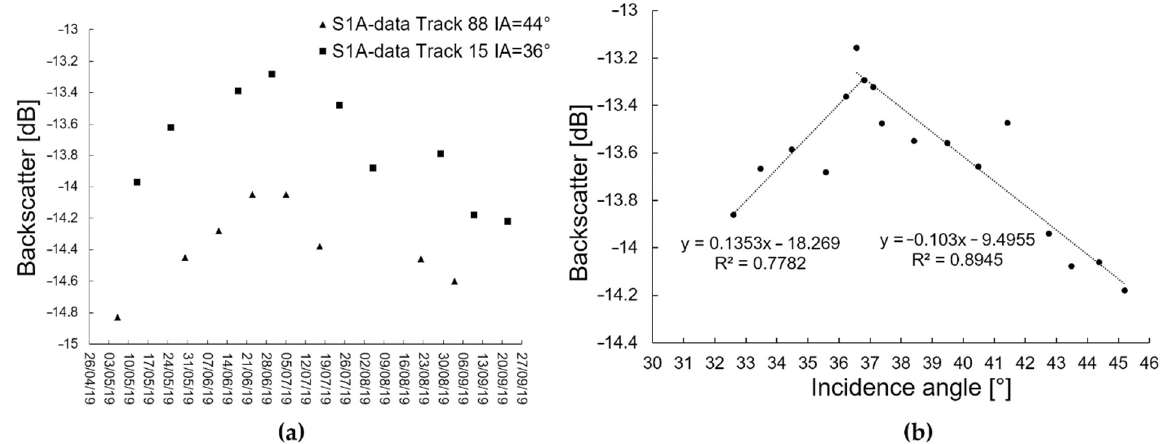
Figure 8. ( a ) Influence of different incidence angles (IA) on the average Sentinel-1 radar backscatter values over all forested areas; ( b ) Linear estimation of relation between mean radar backscatter values and incident angle over all forested areas.